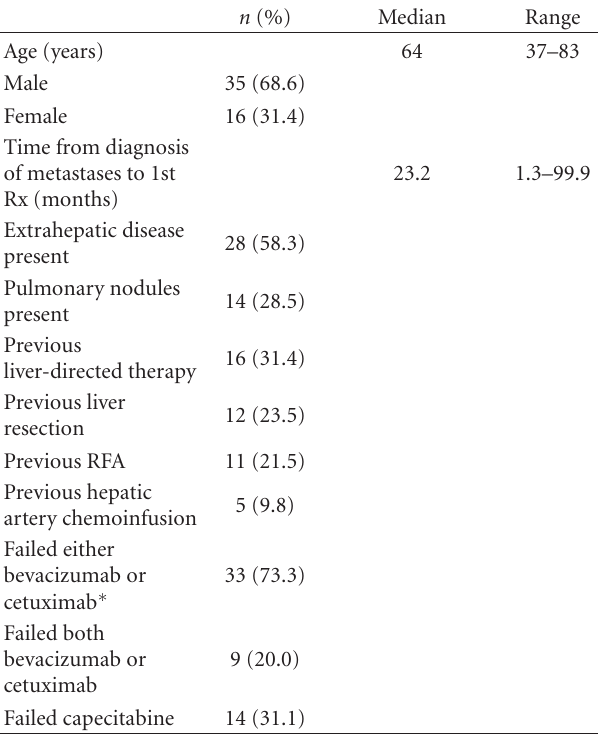
Table 1: Patient characteristics of those treated with 90 Y for liver- dominant metastatic colorectal